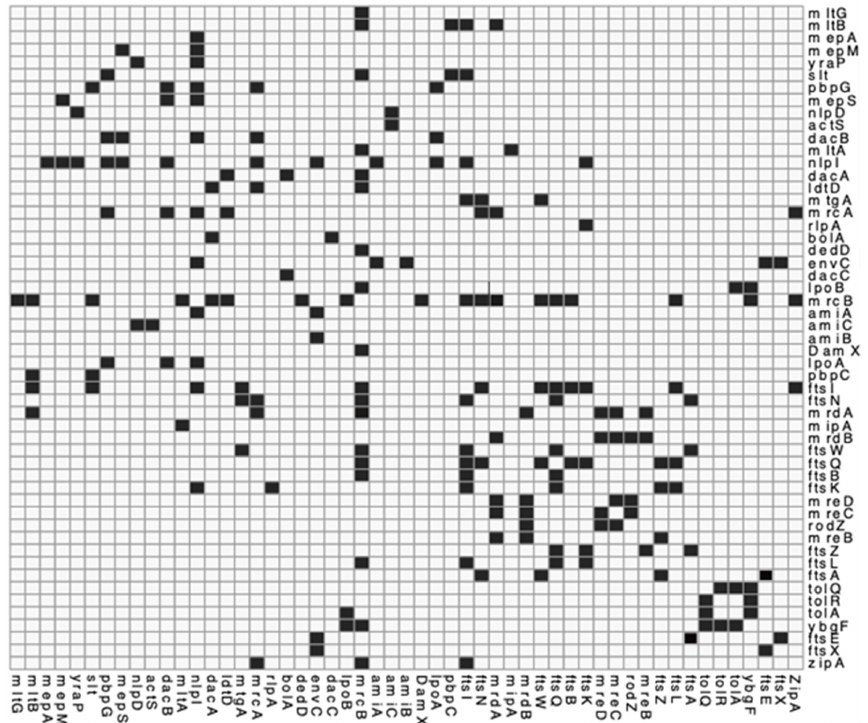
Figure A3. Interaction matrix of PG related proteins. genes or proteins known to interact and confirmed by the literature. Black = confirmed interaction, White = unknown/self/no interaction. Please find attached pg_network.csv file for DOI matrix of confirmed interactions for above. Table A1. Characterised Hydrolases in Gram-negative bacteria.